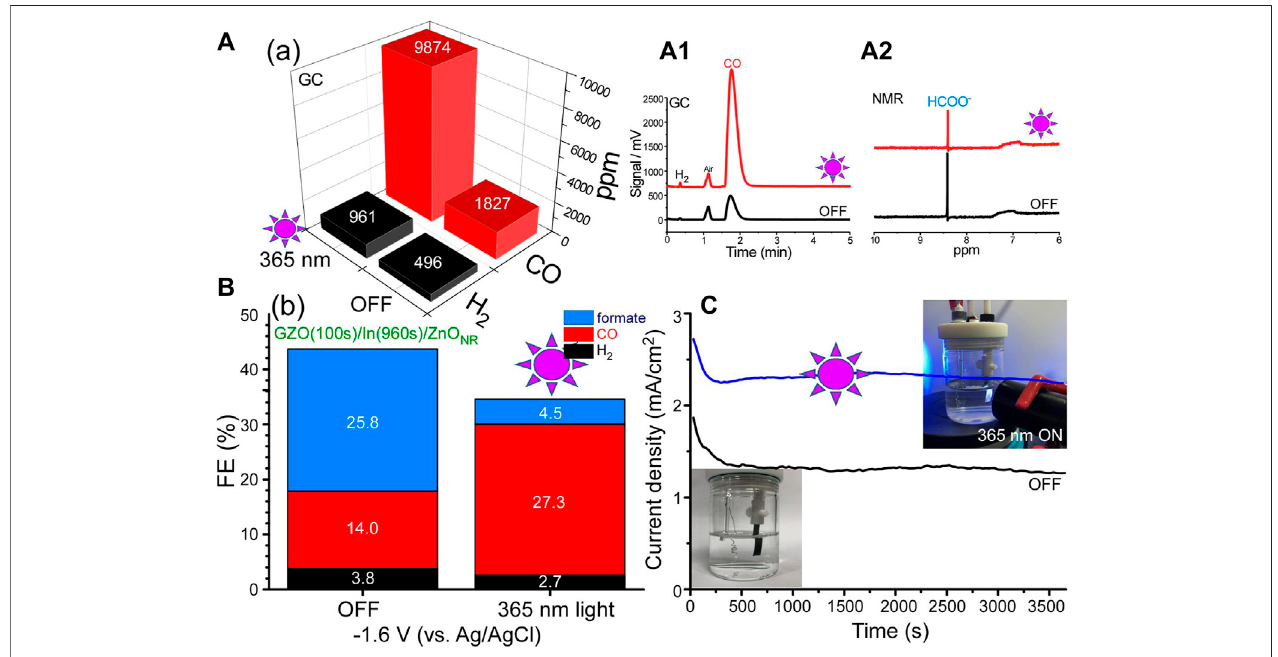
FIGURE5| PhotoelectrochemicalCO 2 reductionppmamounts (A) ofH 2 andCO,GC (A1) andNMR (A2) data,thecorrespondingFE(%) (B) ,andamperometry i-t pro fi les for GZO(100s)/In(960s)/ZnO NR electrode under dark and 365 nm light conditions (C) . Inset photos show the electrochemical cells under dark and 365 nm light.